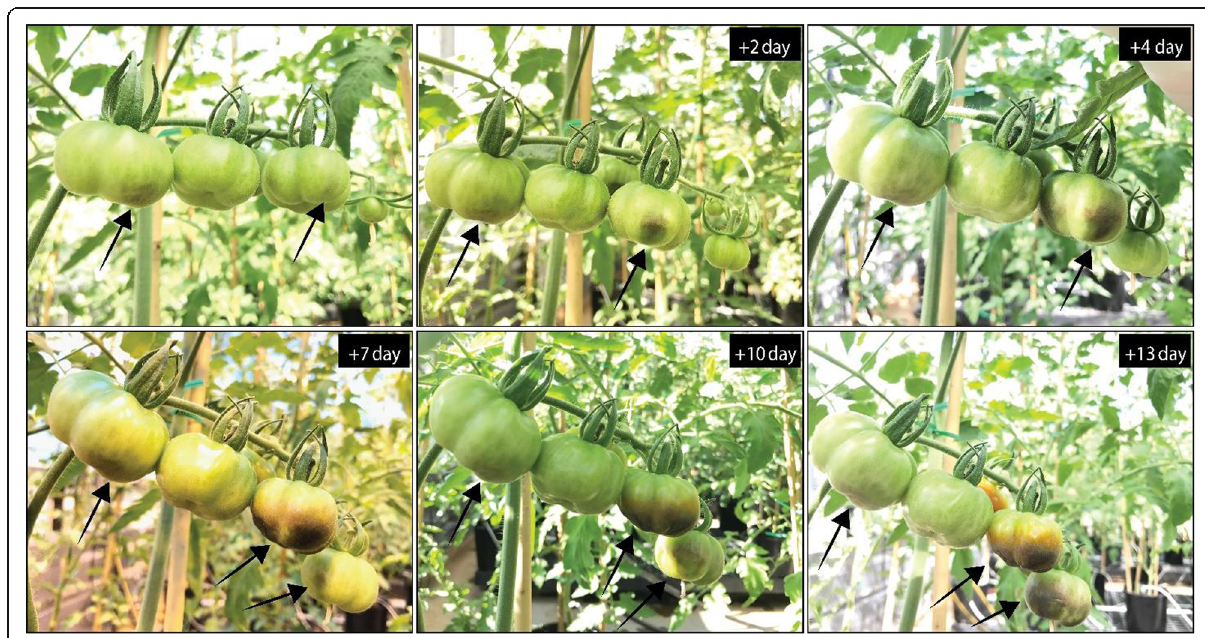
Fig. 2 BER development in four fruits on one inflorescence. After first BER appearance was observed (top left panel), subsequent images were taken at time intervals in days from the initial image. Arrows indicate BER afflicted fruits. The BER on the first fruit did not expand to the entire fruit whereas the last fruit is consumed by BER in a short period of